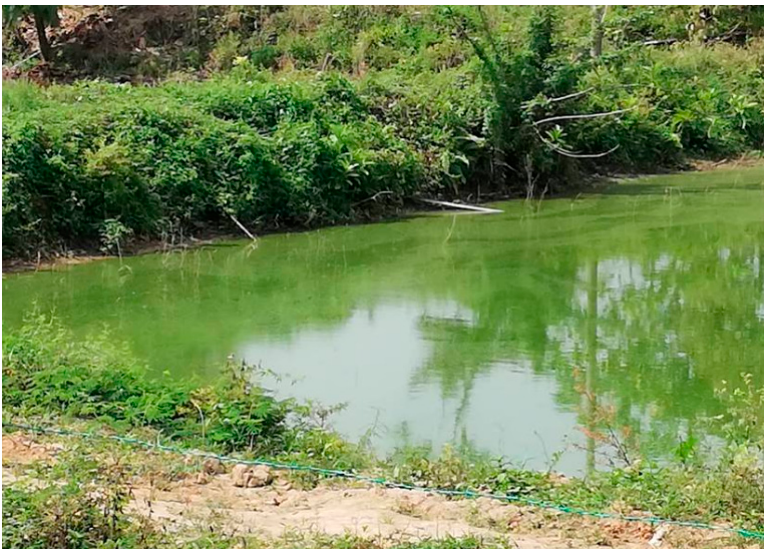
Figure 1. Eutrophic body which currently receives discharged streams from the aquacultural activities in the vicinity.